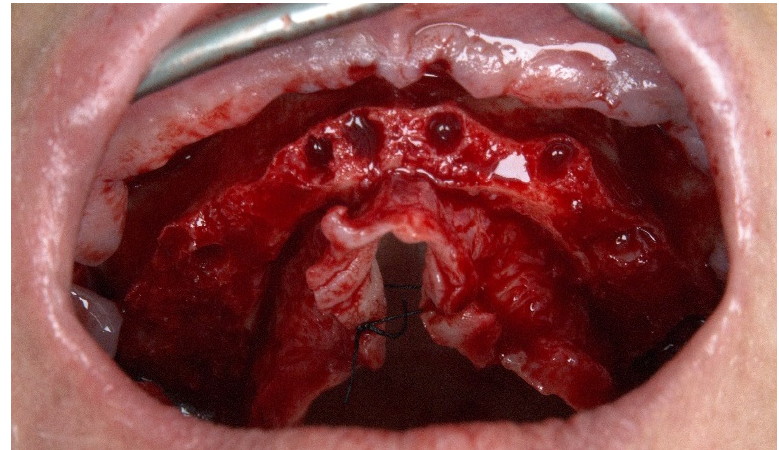
Figure 3. Perioperative photograph after flap opening with teeth extraction and bone regularization.